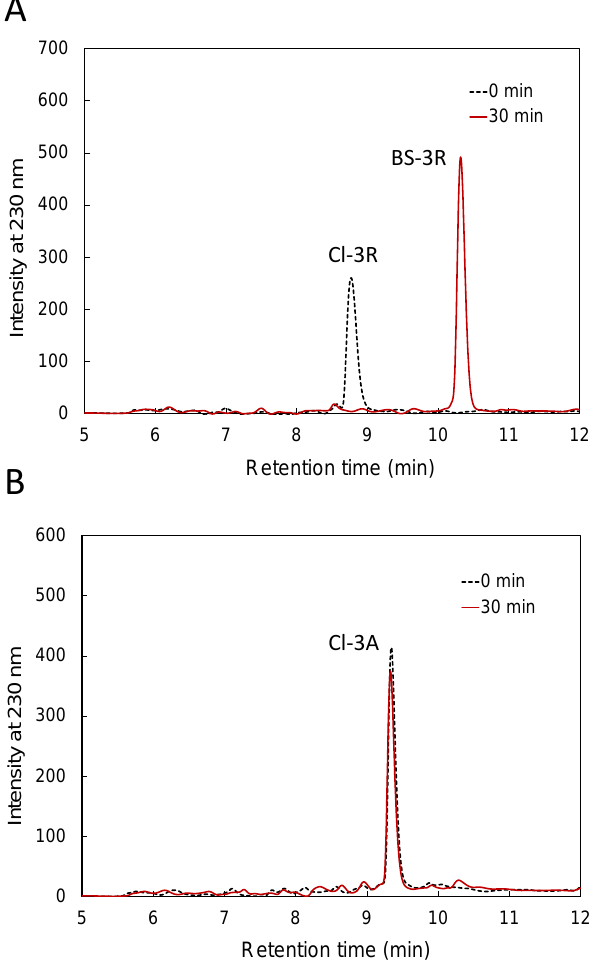
Figure 2. HPLC chromatograms of reaction mixtures of ( A ) Cl-3R and BSH, and ( B ) Cl-3A and BSH at 0 min (black broken lines) and after 30 min (red solid lines).